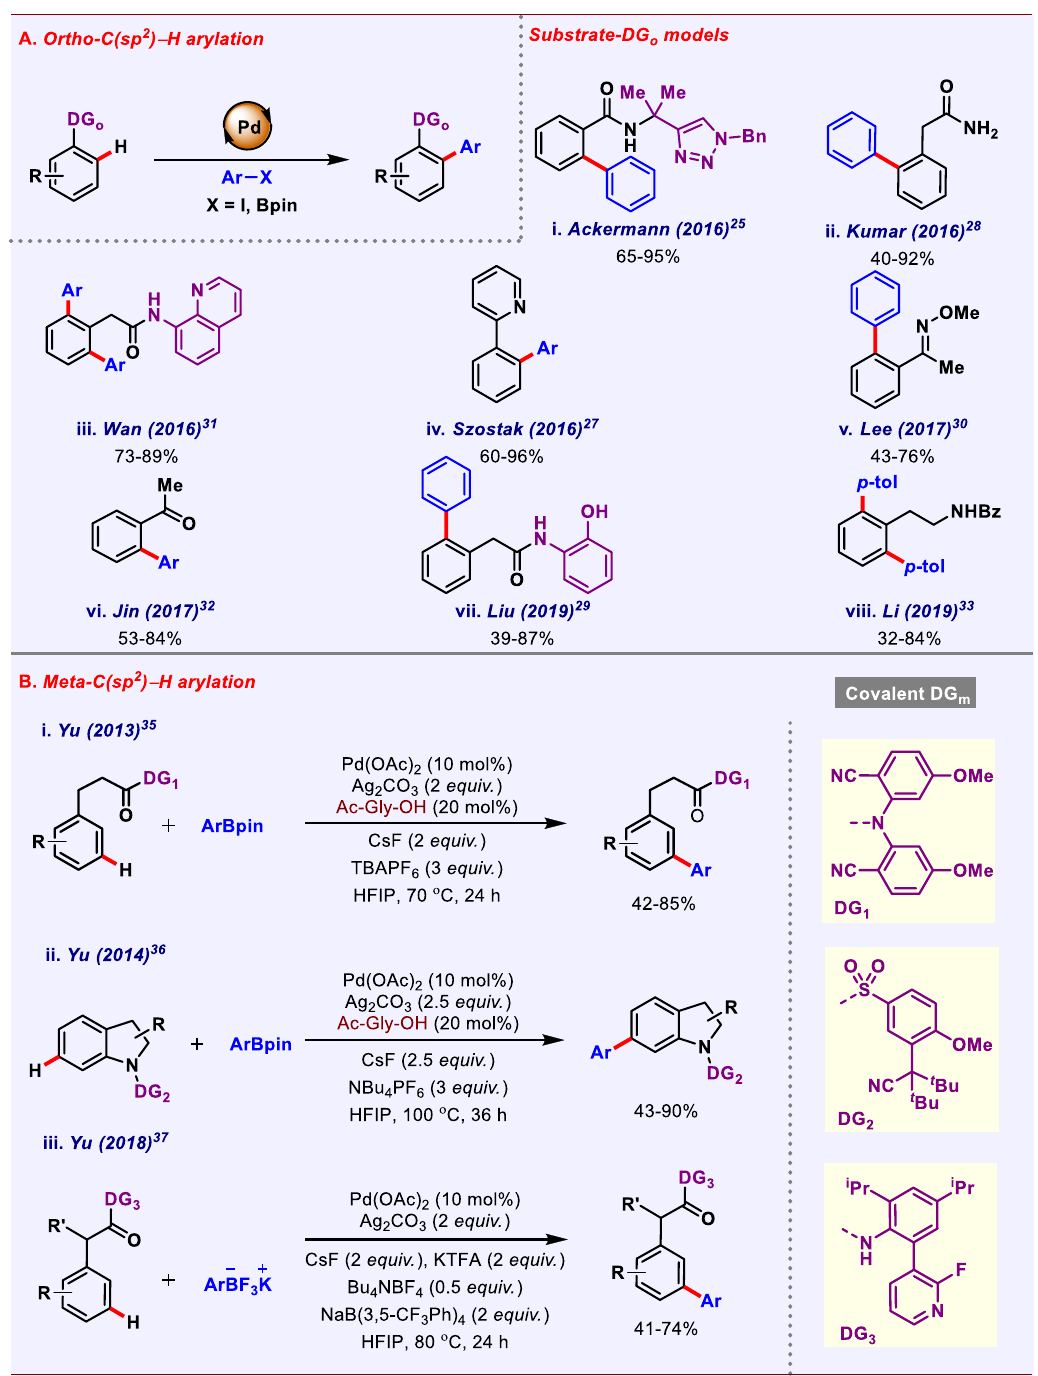
Fig. 2 Covalent directing group-assisted C( sp 2 ) – H arylation of arenes. A ortho -C( sp 2 ) – H arylation of arenes. B meta -C( sp 2 ) – H arylation of